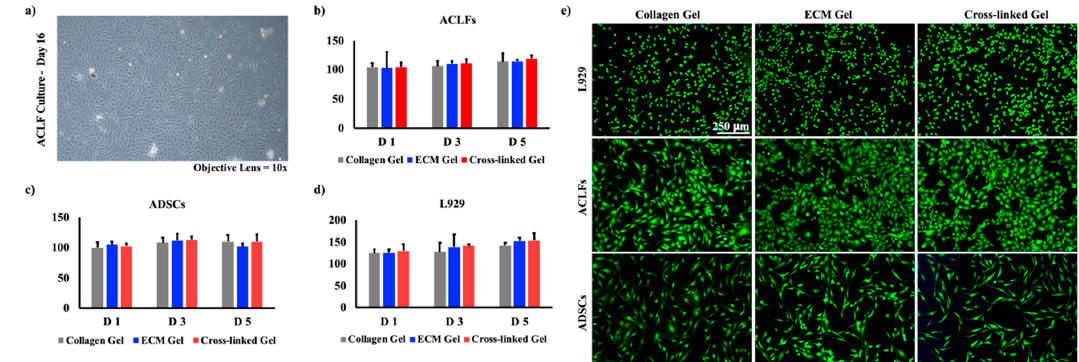
Figure 5. ( a ) Primary anterior cruciate ligament (ACL) fibroblast colony formation; ( b – e ) ACL fibroblast, ADSC, and L929 cell 3-(4,5-dimethylthiazol-2-yl)-2,5-diphenyltetrazolium bromide (MTT) and Calcein acetoxymethyl (AM) cell viability assay, respectively ( n = 3). There were no significant differences in cell morphology and viability among all gels groups (* p > 0.05).